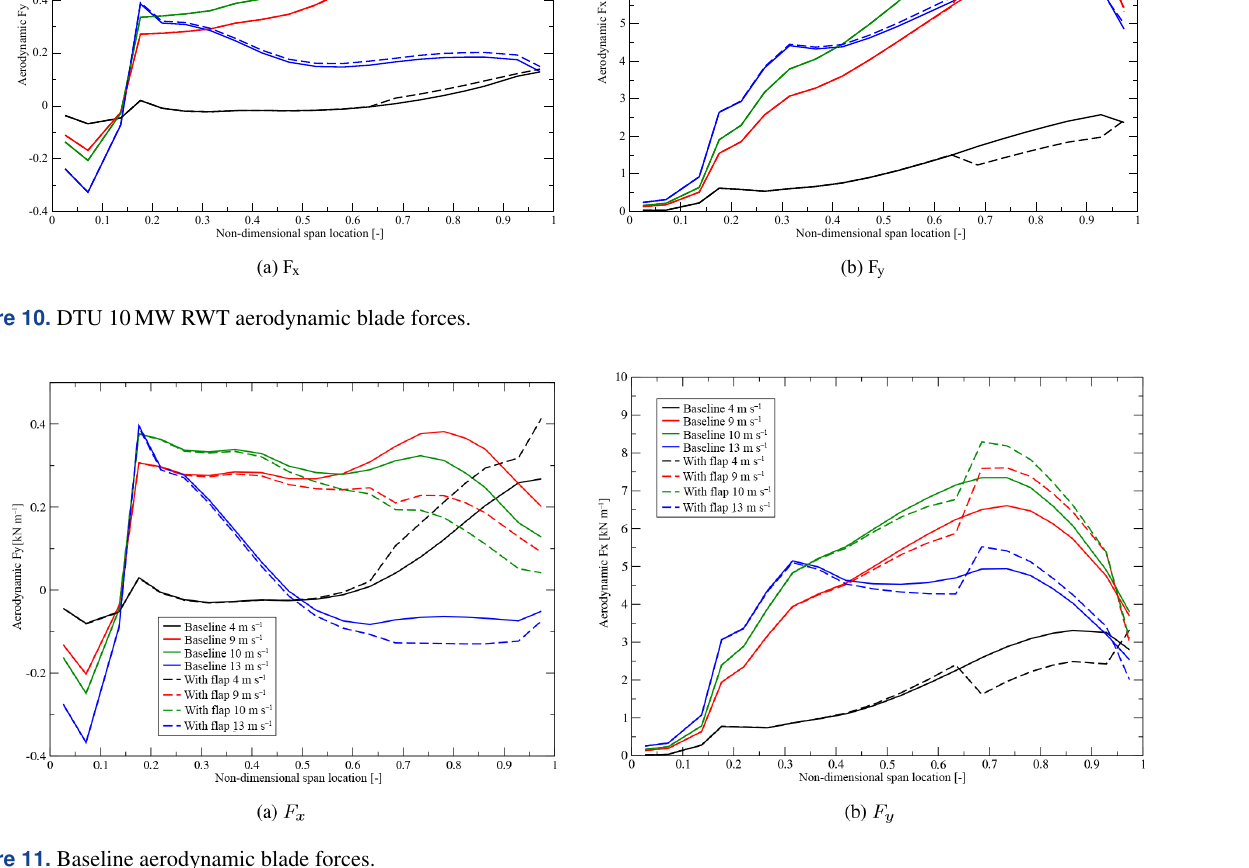
Figure 11. Baseline aerodynamic blade forces.